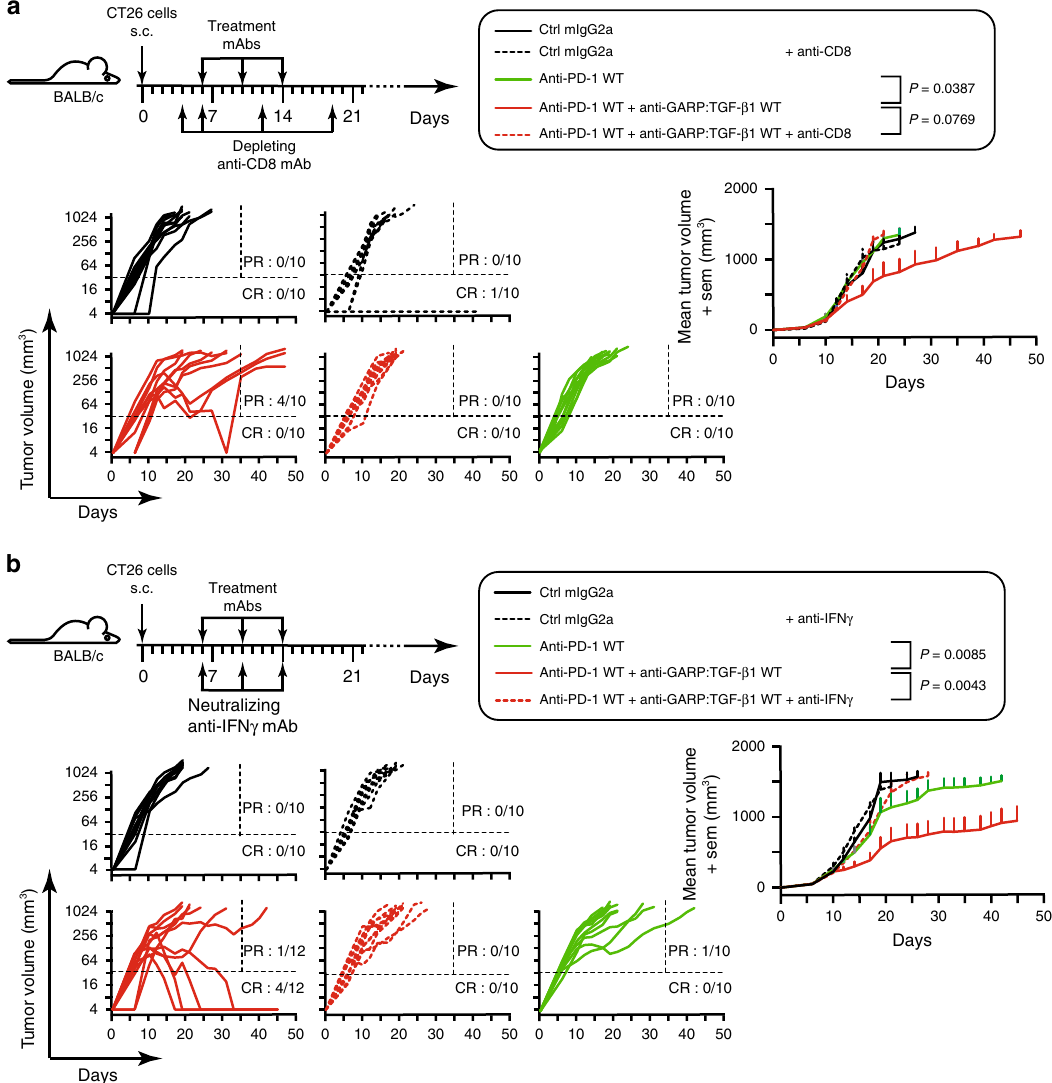
Fig. 6 Anti-tumor ef fi cacy of combined blockade of GARP:TGF- β 1 and PD-1 requires CD8 + cells and IFN γ . a Experimental design as in Fig. 2, except that mice ( n = 10 – 12/group) also received injections of a depleting anti-CD8 antibody at the indicated time points. Graphs on the left show evolution of tumor volumes in individual mice. Ratios indicate the proportions of CR, (mice alive at the end of the experiment with no detectable tumor) and PR (mice alive on day 35 that carry a tumor >32 mm 3 at the time of euthanasia). Dotted horizontal and vertical lines indicate the two arbitrary limits (tumor volume of 32 mm 3 and day 35) used to identify PR and CR. Graph on the right shows evolution of mean tumor volumes + sem in the fi ve treatment groups. P values for relevant comparisons are indicated in the graphical legend and were calculated with a mixed effects model (Liu et al. 46 ; Sugar et al. 45 ), with a post-hoc Tukey ’ s test for multiple comparisons. b As in a , except that mice received a neutralizing anti-IFN γ from the MSigDB public database (hallmark gene sets, http:// software.broadinstitute.org/gsea/msigdb/) or from our own experimental data (experimental gene sets, Supplementary Data 2). Hallmark signatures of response to in fl ammation, IFN γ , TNF α , or IL-2 were signi fi cantly enriched at the left end of the gene list ordered by correlation with proportions of GARP + Tregs (Enrichment Score >0.5 and False Discovery Rate <0.1%;